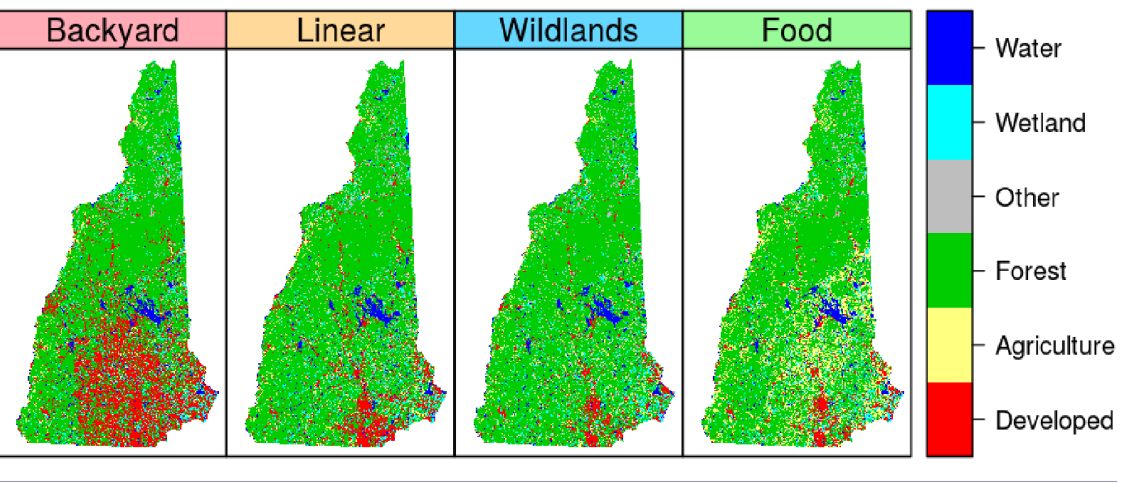
Fig. 3. Scenarios for land cover in 2100. Maps are shown for the four land-cover scenarios: Backyard, Linear, Wildlands, and